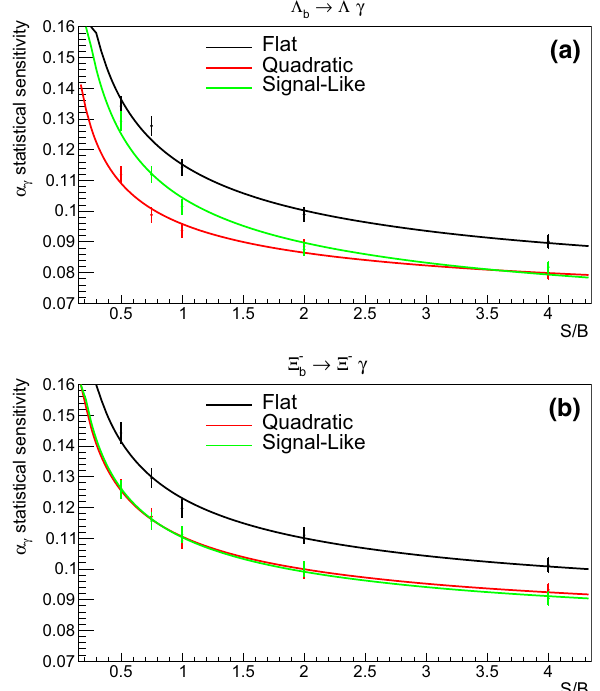
Fig. 7 Sensitivity to the photon polarization as function of the signal over background ratio for Λ 0 ( a ) and Ξ − ( b ) including background b b effects. Dots with errors corresponds to the fit results. A function A + √ B / x is superimposed for better